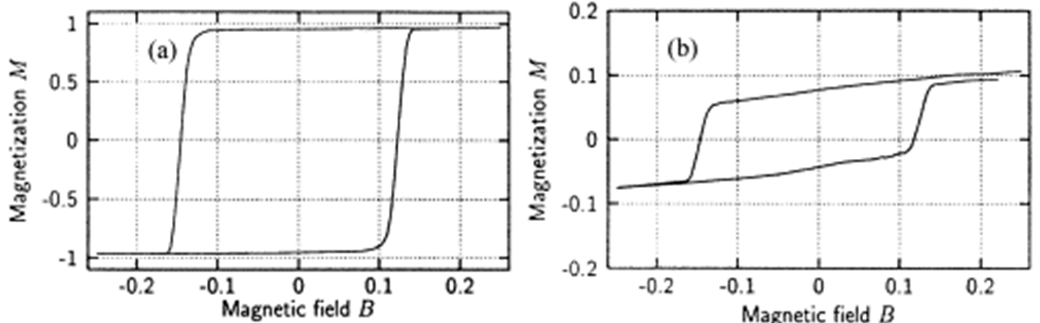
Figure 4. Hysteresis loops of ( a ) the ferromagnet and ( b ) the interface layer of the AFM. Reprinted with permission from [48], Copyright 2001 Elsevier.